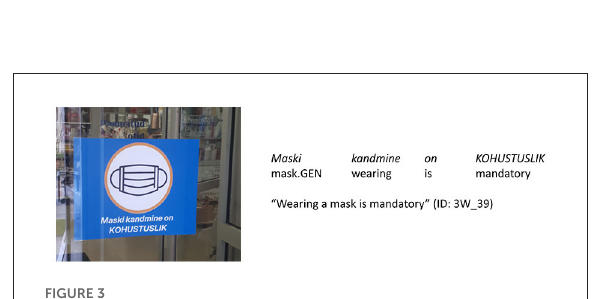
FIGURE3 Type of person usage “neither 1st nor 2nd person” (expressions_of_authority_NO + imperative_NO).